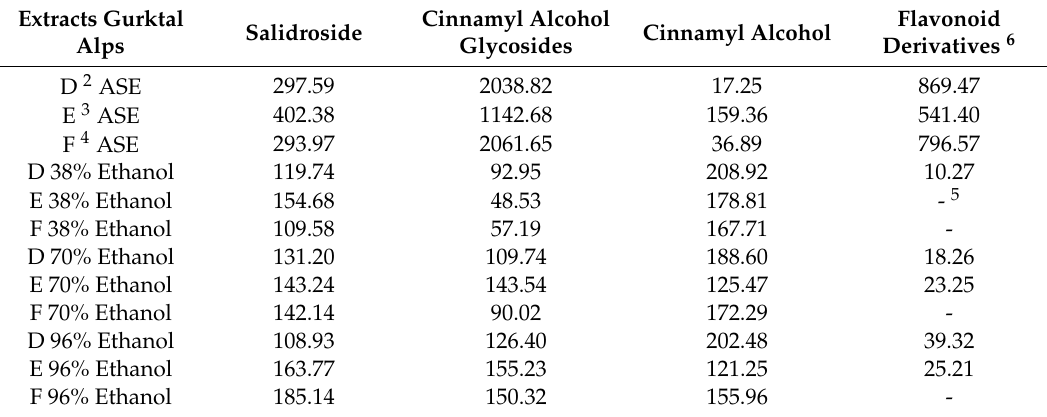
Table 8. Total contents for investigated substance groups for extracts from collection site Gurktal Alps (mg / 100 g plant material 1